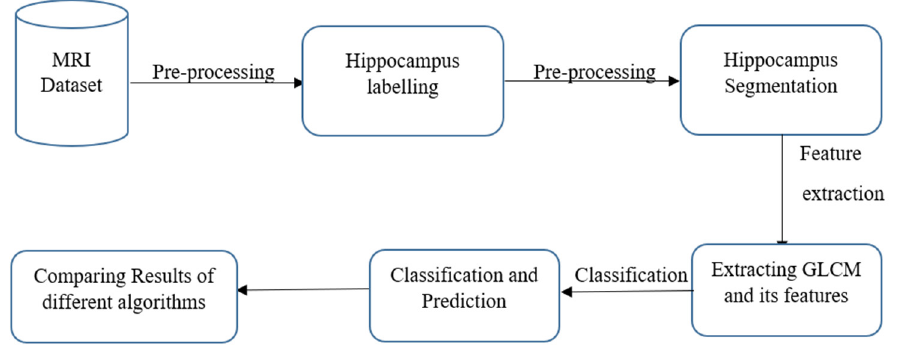
Figure 1. Process